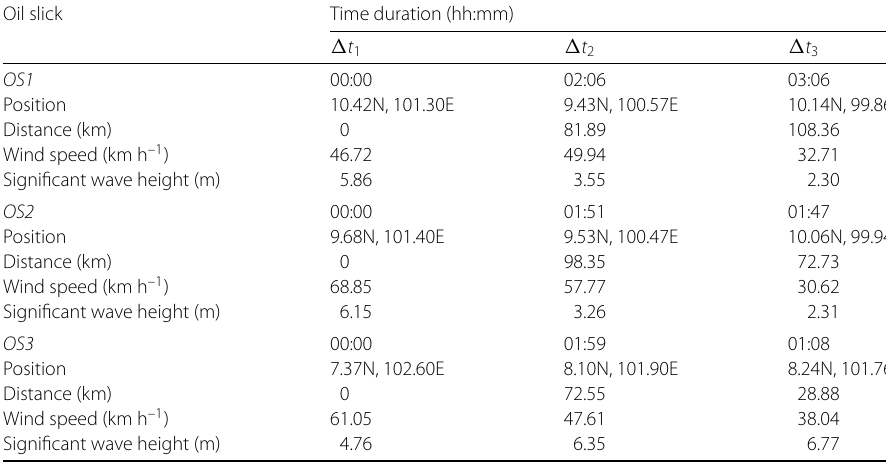
Table 3 The positions and the traveling distances of each of the three oil slicks and their corresponding wind speeds and significant wave heights at the three different times on 4 January 2019, a day with the tropical cyclone Pabuk Oil slick